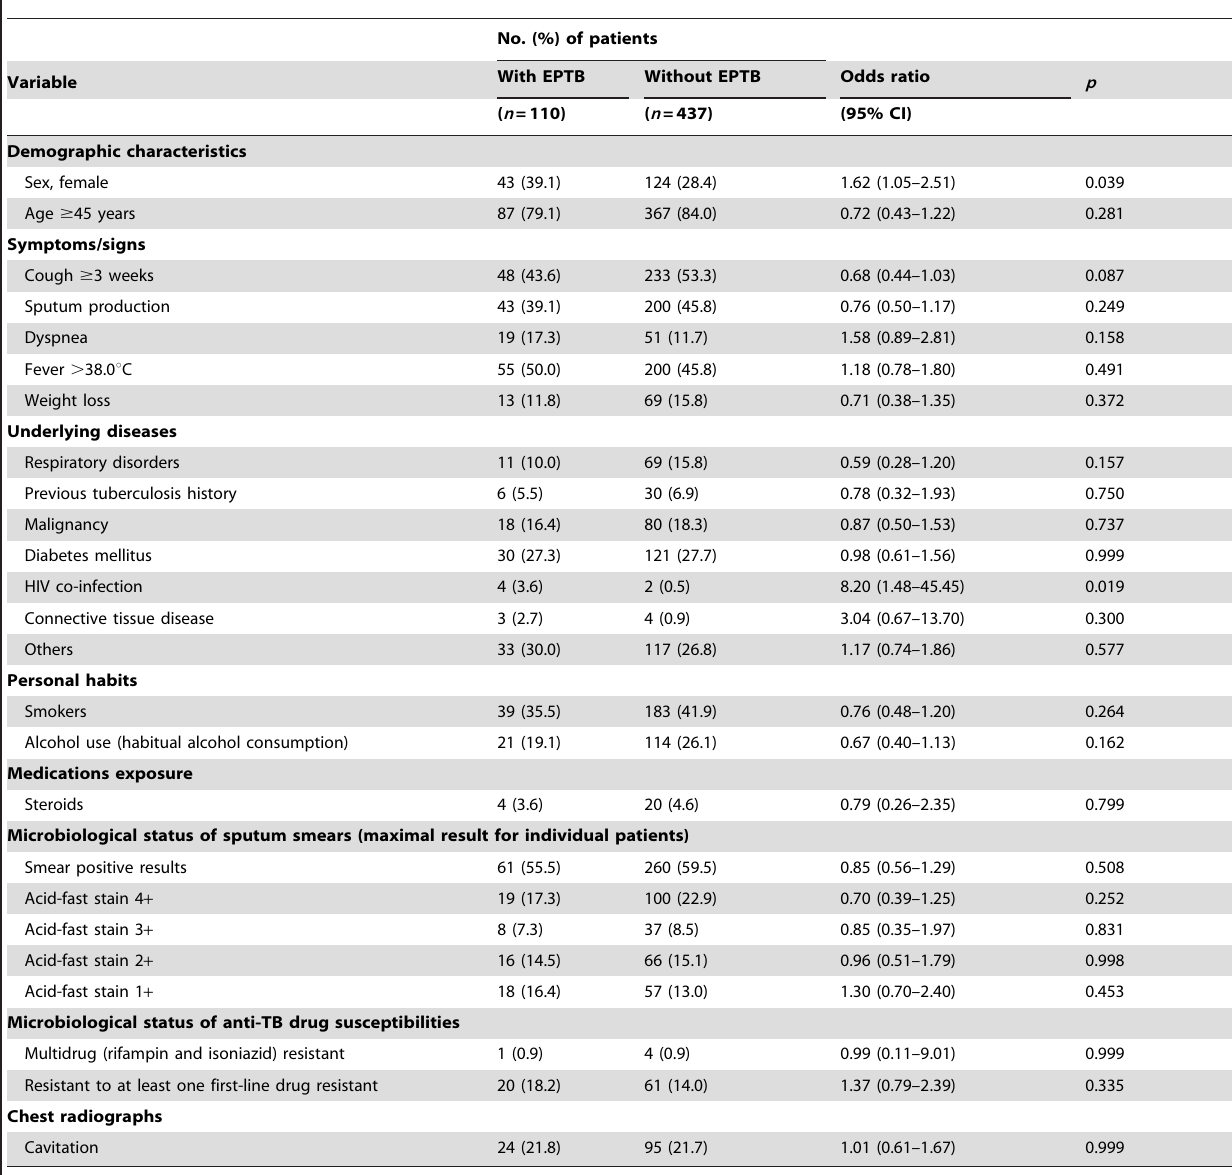
Table 3. Univariate analysis of factors associated with concurrent EPTB in PTB patients, from the KMUH database ( n =